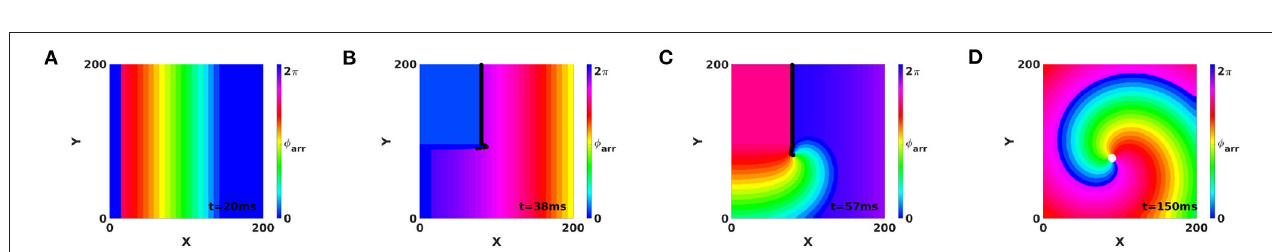
FIGURE 10 | Creation of a PS from a PDL using a S1-S2 protocol with AP kinetics, showing coexistence of PDL and PS in models that generate circular-core spirals. Snapshots (A–D) shown at times t